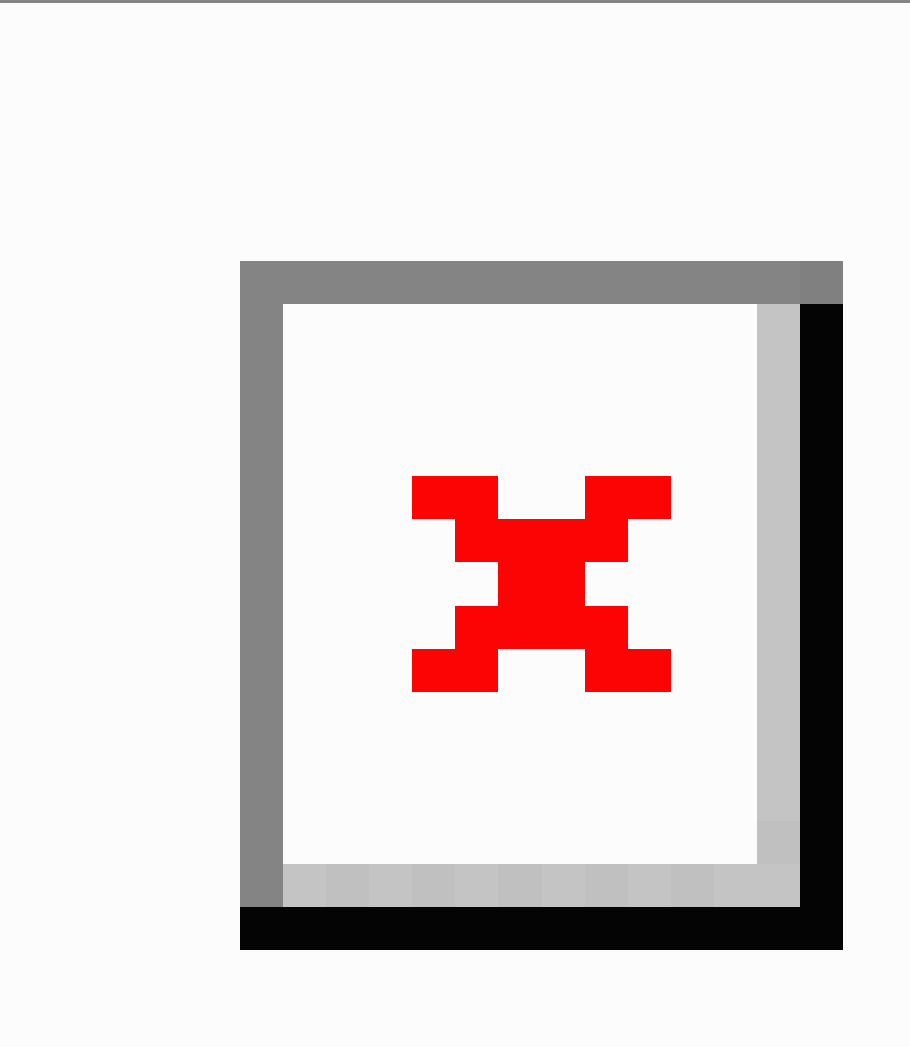
Figure 2. Quantity of cannabis use during each day of the 90-day (30-days for participant 1) baseline and 2-week follow-up periods for each participant, as measured by the MSHQ (Participant 1) and TLFB (Participants 2-4). Vertical dashed line indicates the cessation day for each participant. Because Participant 2 did not complete the follow-up assessment, his data are not presented. Horizontal gray solid lines represent mean cannabis use during the represented timeframe (baseline, 2-week